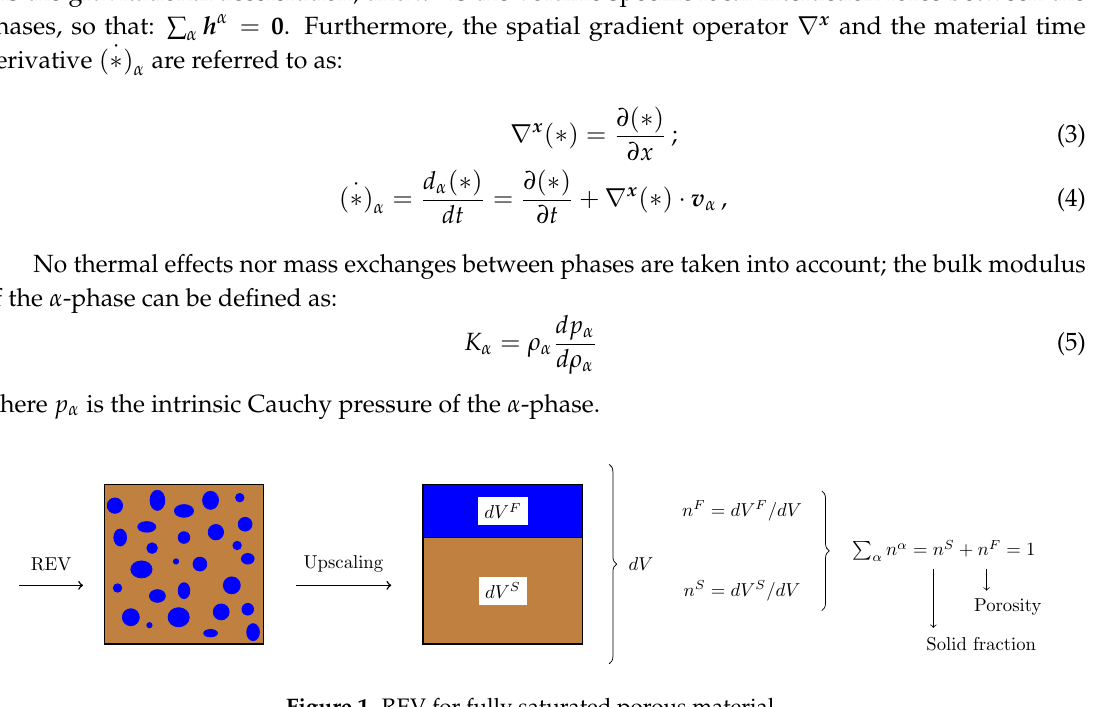
Figure 1. REV for fully saturated porous